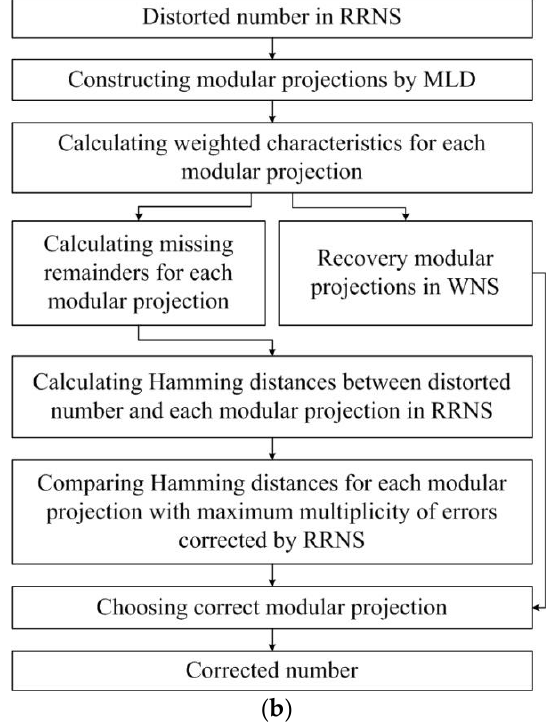
Figure 1. Modular projection methods with MLD: ( a ) original, ( b ) modified.